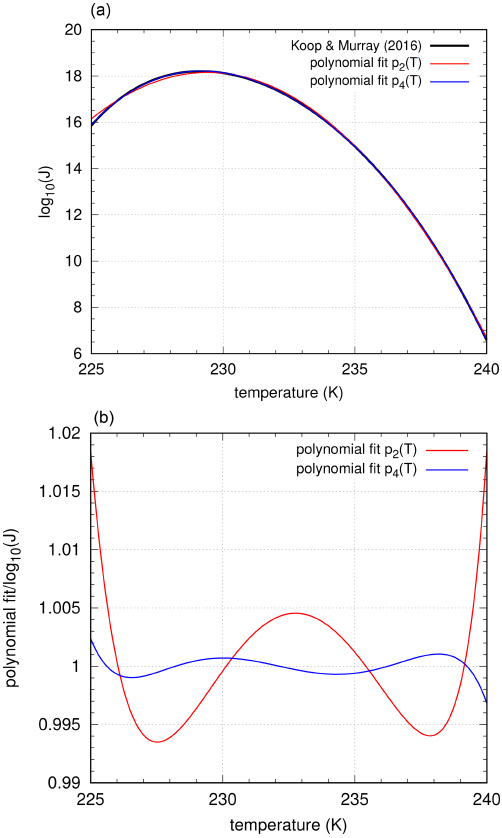
Figure C1. Polynomial fits of low degrees for the nucleation rate as given by Koop and Murray (2016). (a) Reference and fits p 2 ( T ) and p 4 ( T ) and (b) ratio of reference and fits p 2 ( T ) and p 4 ( T